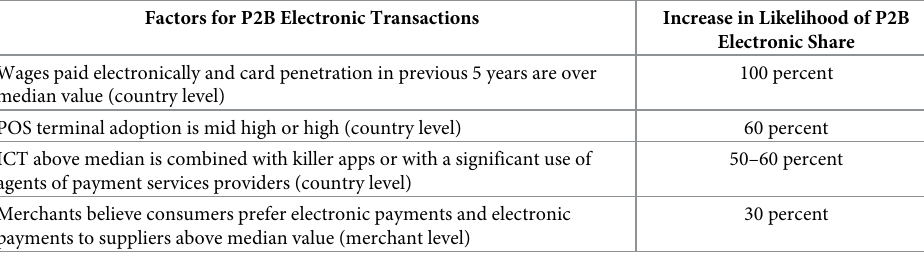
Table 3. Factors influencing share of electronic P2B